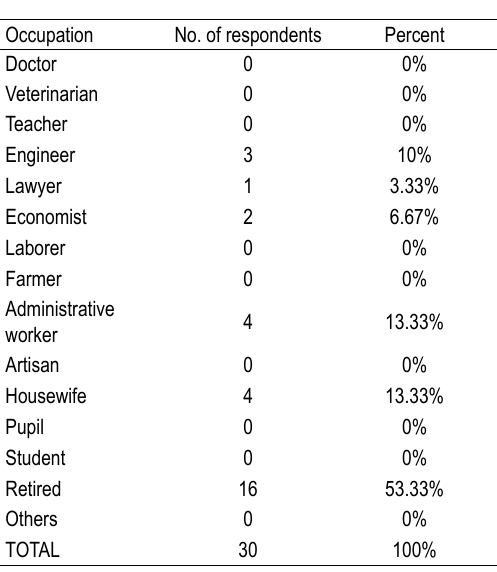
Table 2. Structure of respondents by